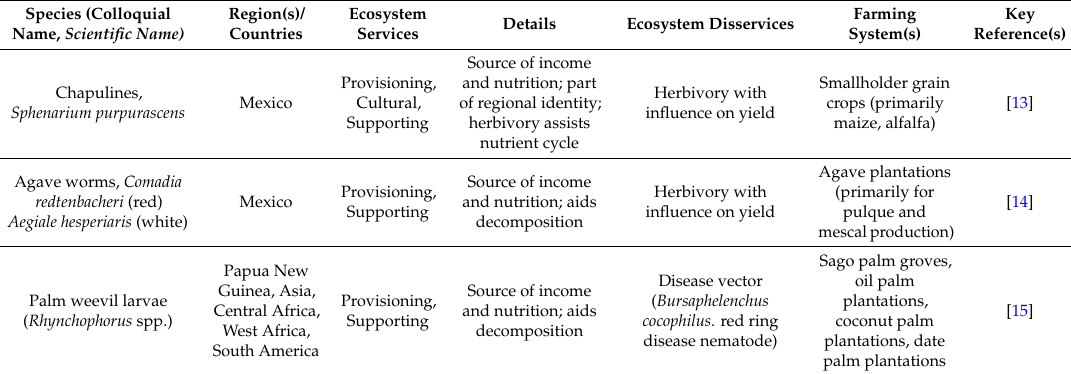
Table 1. Summary of commercially available edible insect species closely associated with agricultural systems, and the ecosystem services and disservices they provide. Species (Colloquial Name, Scientific